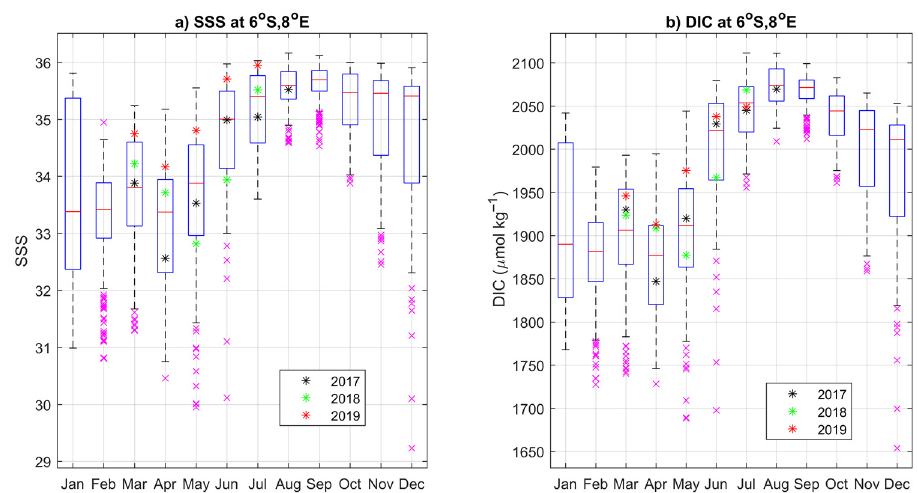
Figure 6. ( a ) Distribution of SSS at 6° S, 8° E grouped by month using SSS observations from 2006 to 2019 (the data at 6° S, 8° E are for the periods 28 June 2006 to 10 June 2007 and 5 July 2013 to 8 August 2019). The central mark of the box corresponds to the median with the bottom and top edges of the box indicating the 25th and 75th percentiles. The whiskers extend to the extreme data points and the crosses (×) are considered as outliers. ( b ) Same for the distribution of DIC at 6° S, 8° E calculated with Equation (3) using the SSS and SST recorded at the PIRATA mooring. The monthly measurements of SSS and DIC calculated from fCO 2 at the PIRATA mooring are indicated for 2017 (black stars), 2018 (green stars) and 2019 (red stars).